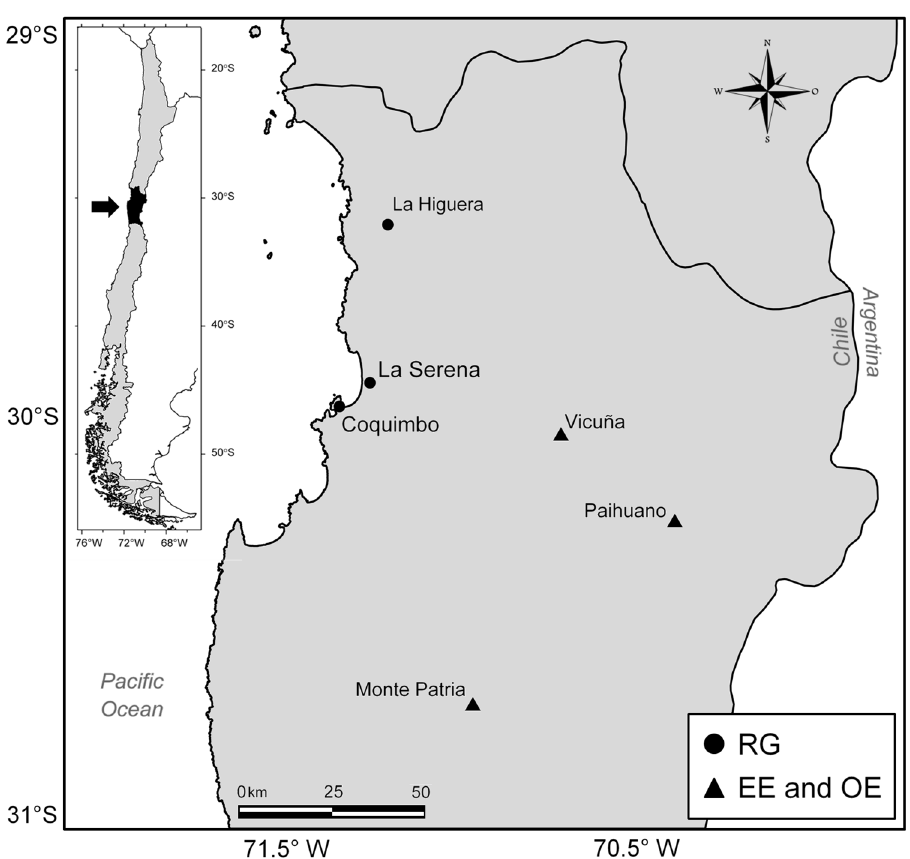
Fig 1. Locations of the Coquimbo Region in Chile from where volunteers were recruited. RG ( ● ) was composed of people living in rural or urban coastal areas. Individuals belonging to EE and OE groups ( ▲ ) were recruited from rural areas with intense agricultural activity (Vicu ñ a, Paihuano, Monte